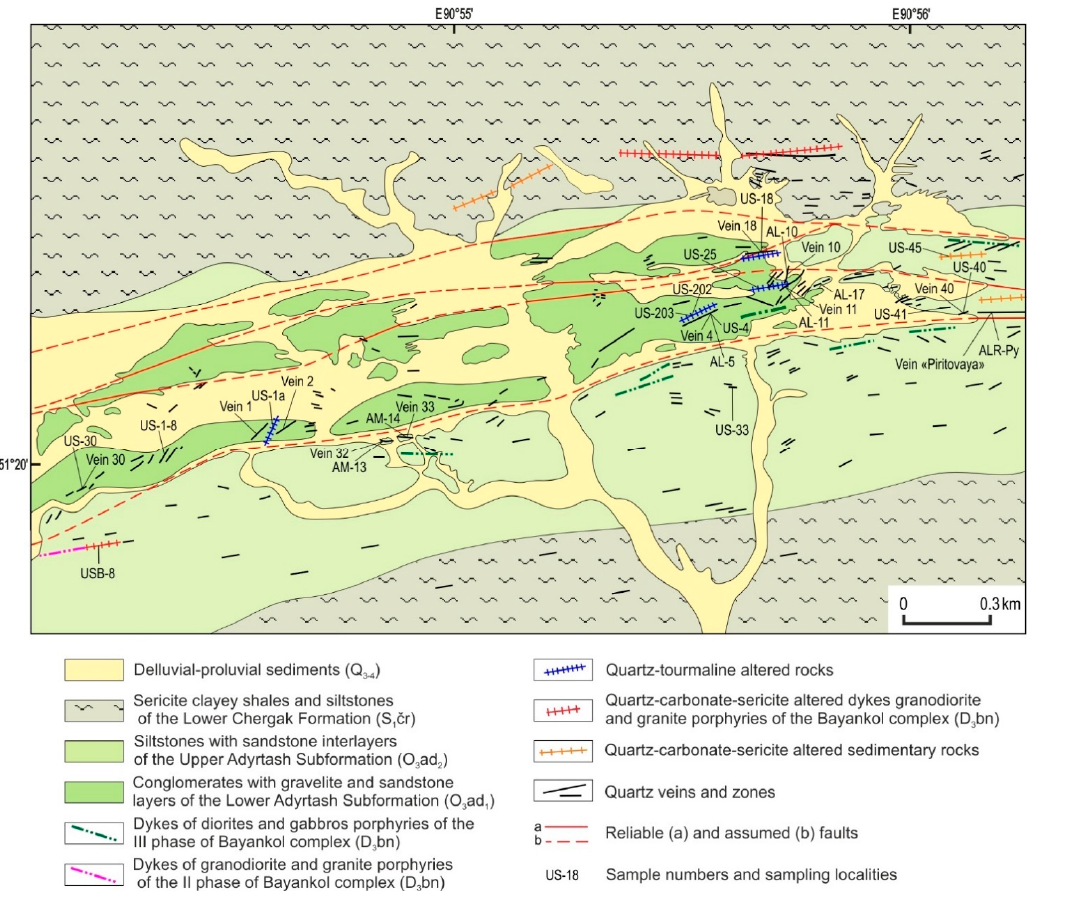
Figure 2. Geological scheme of the Ulug-Sair occurrence. The Au in quartz veins ranges from 0.2 to 286 g/t, and Ag ranges up to 300 g/t [28]. The Au resources, according to prospecting work, are 20 t with an average Au grade of 2 ppm [33]. The Cu sulphides in quartz veins are a proxy for gold. A positive correlation between Au and Cu, B, Ag, Sb, As, Te, Bi, Mn, Ba, Sr, Pb, Mg, Mo, Cd, Zn, and W was identified [34].